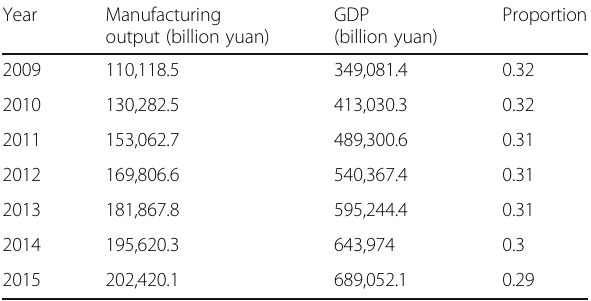
Table 1 The proportion of manufacturing outputs in GDP